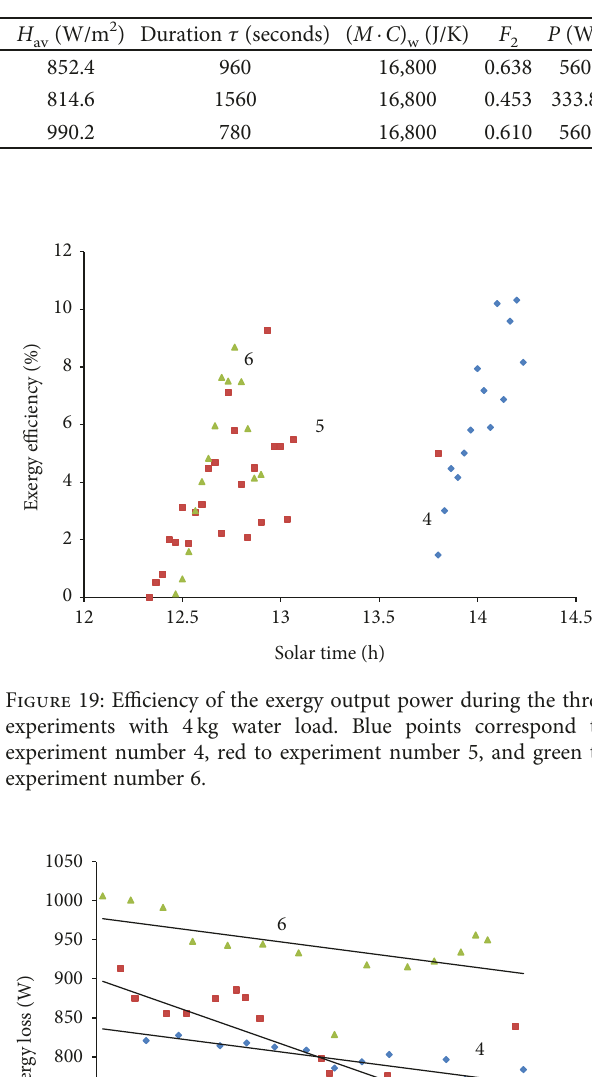
Table 3: Calculation of the second fi gure of merit and the cooking power for the dual parabolic re fl ector solar cooker for experiment numbers 4, 5, and 6.